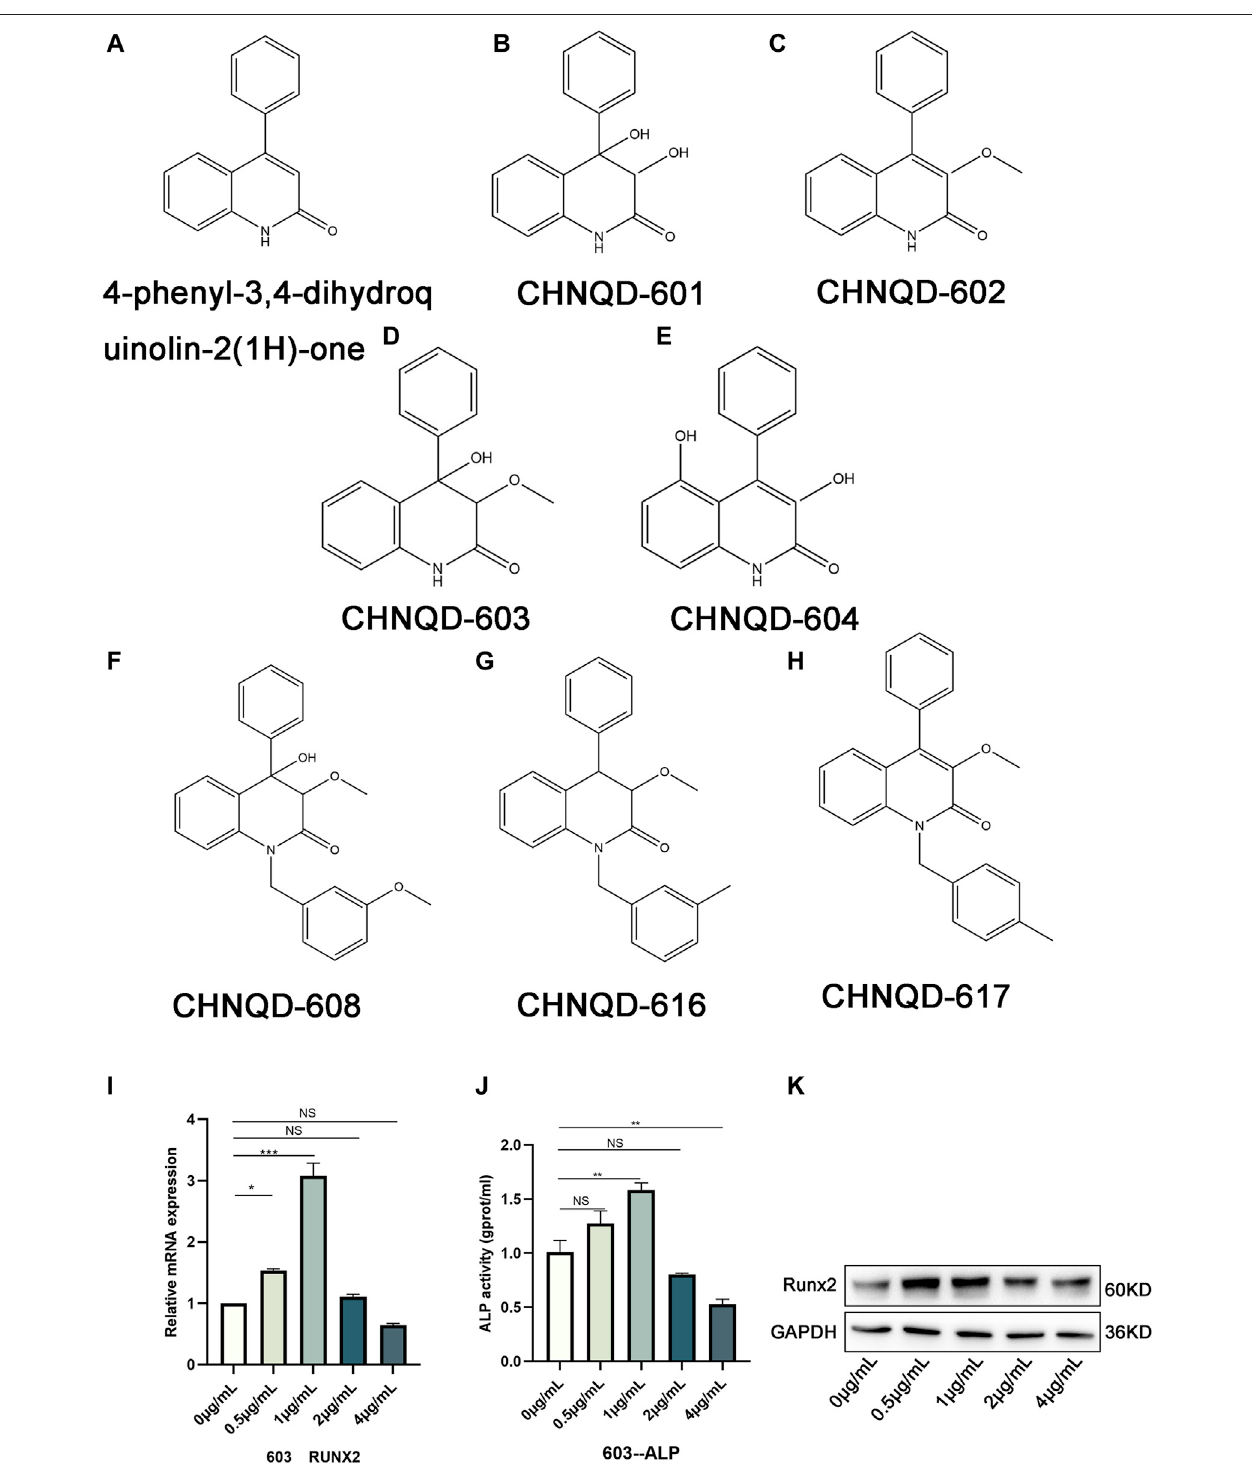
FIGURE 1 | The structure of 4-phenyl-3,4-dihydroquinolin-2(1H)-one and its derivatives. (A) The structure of 4-phenyl-3,4-dihydroquinolin-2(1H)-one. (B – H) Structuresofaclassof4-phenyl-3,4-dihydroquinolin-2(1H)-onealkaloidderivatives. (I) qRT-PCRwasusedtoobservetheexpressionoftheosteogenesis-relatedgenes Runx2. (J) ALP activity assay was applied to access the early osteogenic differentiation of BMSCs. (K) WB was adopted to investigate the osteogenesis-related protein Runx2. Quantitative data were presented as the mean ± SD (n (cid:1) 3) (* p < 0.05, ** p < 0.01, *** p < 0.0001).